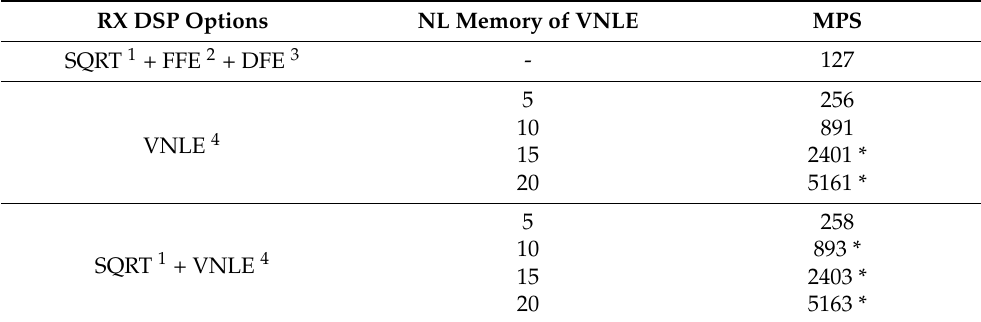
Figure 7. Maximum ODN loss as a function of fiber length targeting BER T = 10 − 2 , for 50G-O/E devices. The normalized amplitude V PP , I / V π and the pre-compensated length L C are optimized for each case. The transmitted optical power TOP = 15 dBm. Solid: VNLE, Dashed: SQRT + VNLE. Table 1. Complexity comparison in terms of multiplication per sample (MPS) for different RX DSP